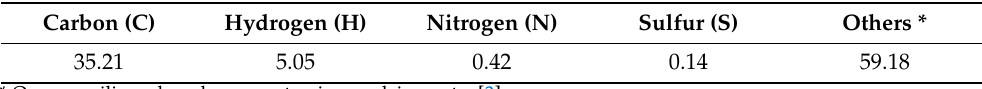
Table 2. Elemental analysis results of rice husk (dry basis wt%). Carbon (C) Hydrogen (H) Nitrogen (N) Sulfur (S) Others